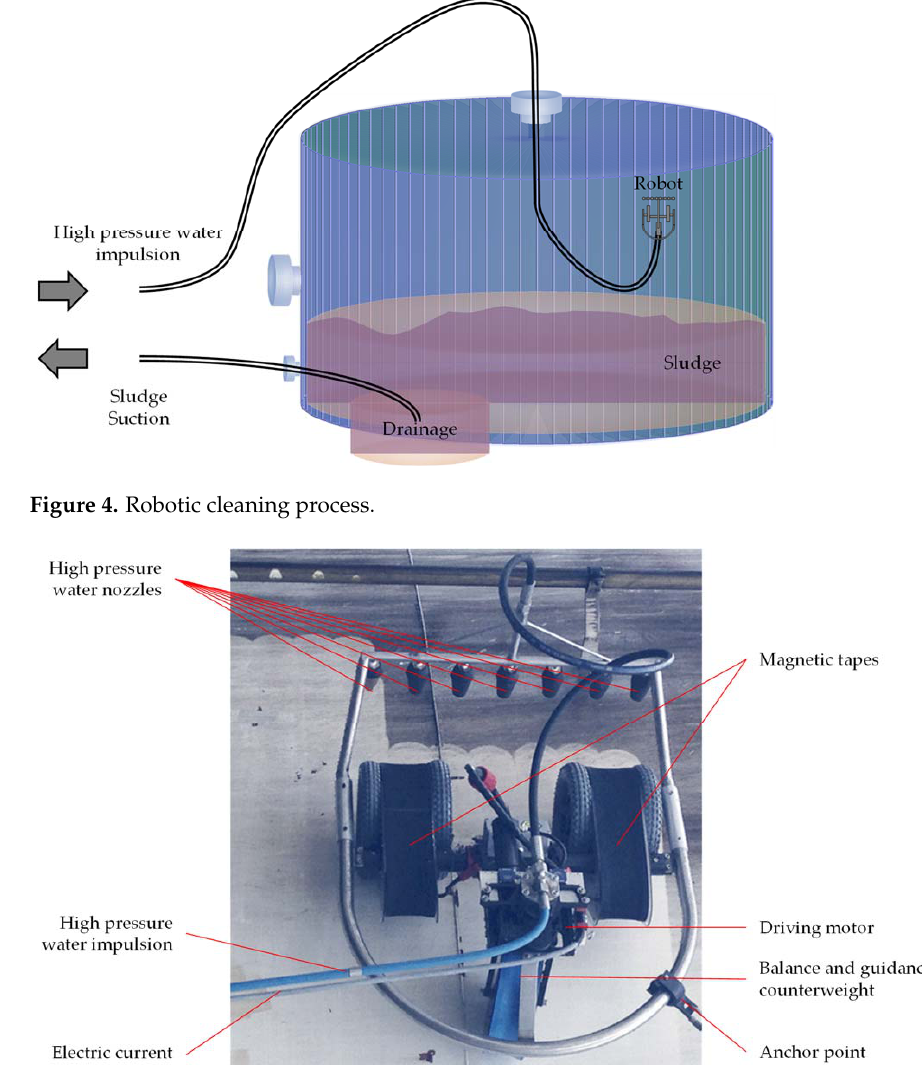
Figure 5. Detail of magnetic robot in operation.